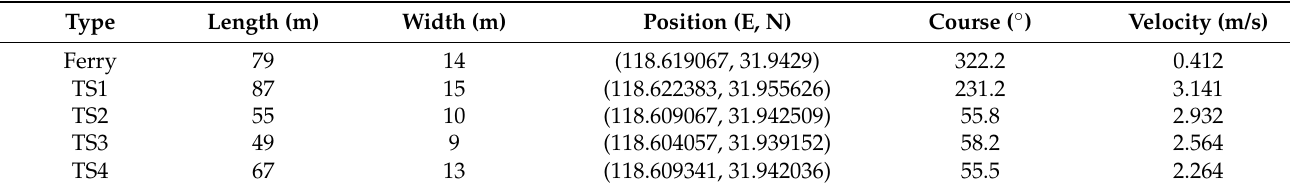
Table 4. Dynamic and static parameters.